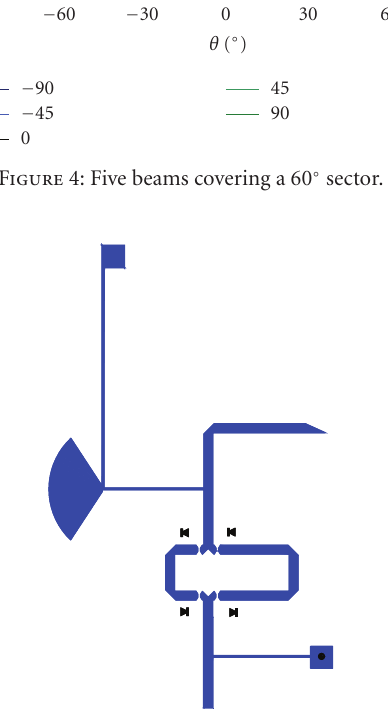
Figure 5: PIN diodes and microstrip delay lines phase shifter